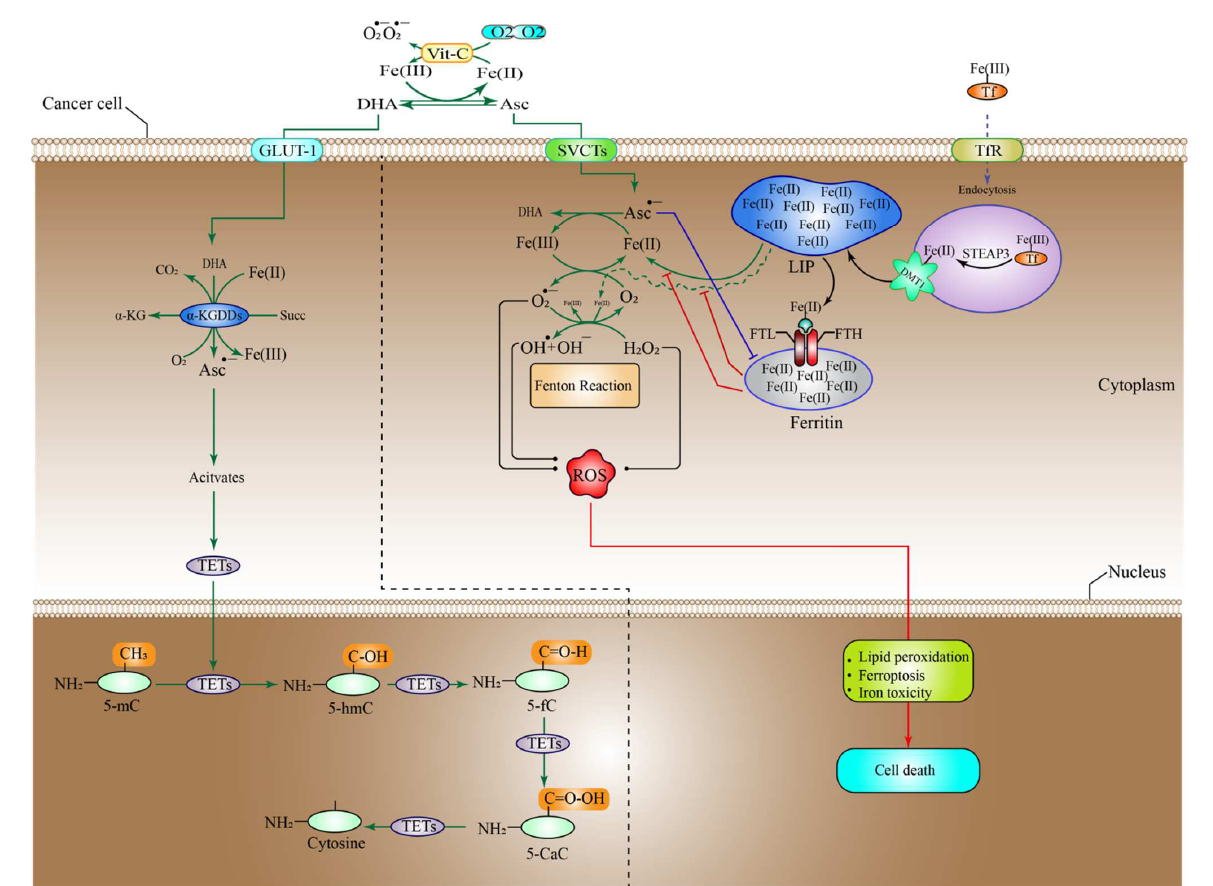
Figure 1 . High-dose Vit-C targets the LIP imbalance and activates TET enzymes. First, the